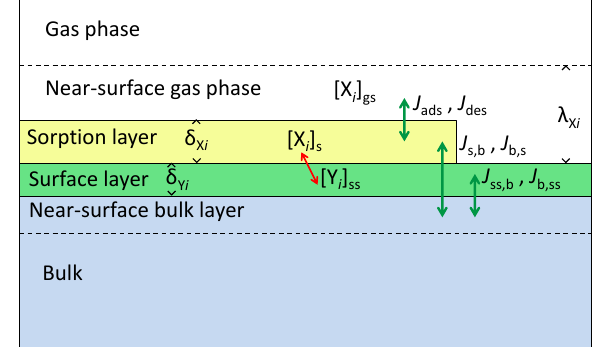
Figure 1. Kinetic model for an organic layer at the air–water in- terface; δ X i and δ Y i are the thicknesses of sorption and surface layer. λ X i is the mean free path of X i in the gas phase. The red arrow shows chemical reactions. The green arrows show the trans- port